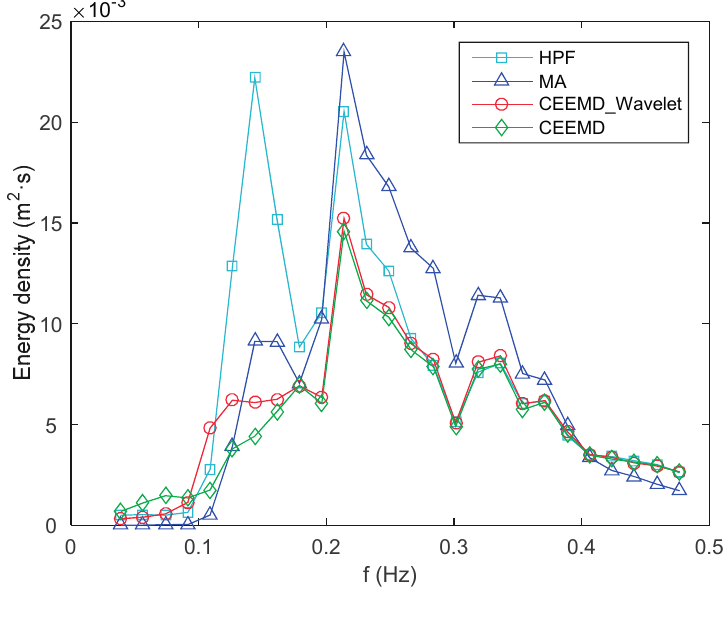
Figure 6. Smoothed power spectrum. Table 1. Comparison of wave parameters among different